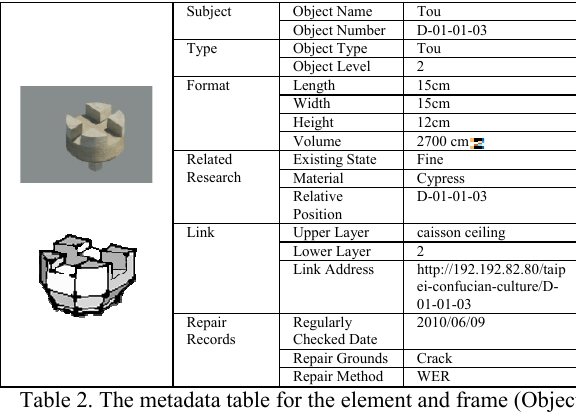
Table 1. Caisson ceiling wooden elements metadata